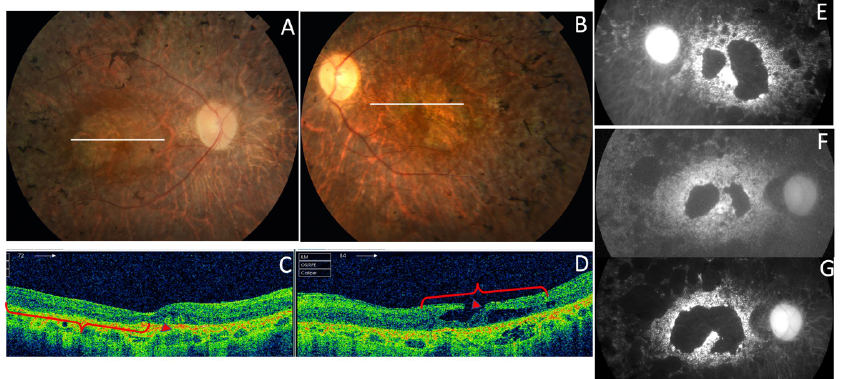
Figure 17. The RP phenotype in the p.Pro216Ser PRPH2 gene mutation from F7-III-1. ( A,B ) The ocular fundus had pigmented spiculae in the periphery; the SD-OCT images ( C,D ) and autofluorescent images show atrophic macular areas of the LE ( E ) and RE ( F ) at the age of 48 years that increased 19 years later in the RE ( G ), the photopic ff ERG was unrecordable at this